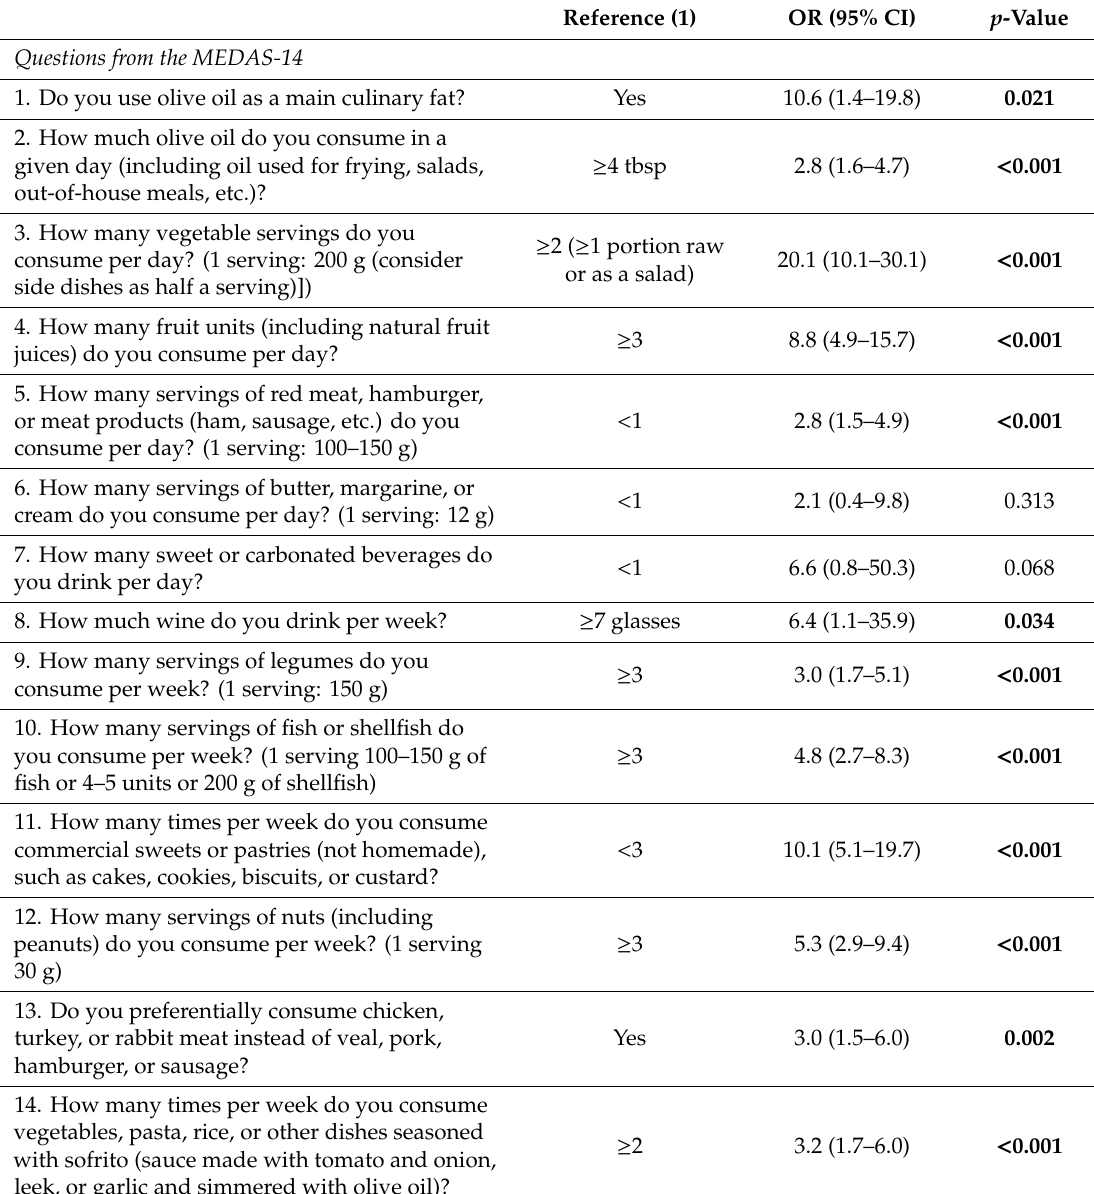
Table 4. Logistic regression model predicting high adherence to the MD based on each item of the MD